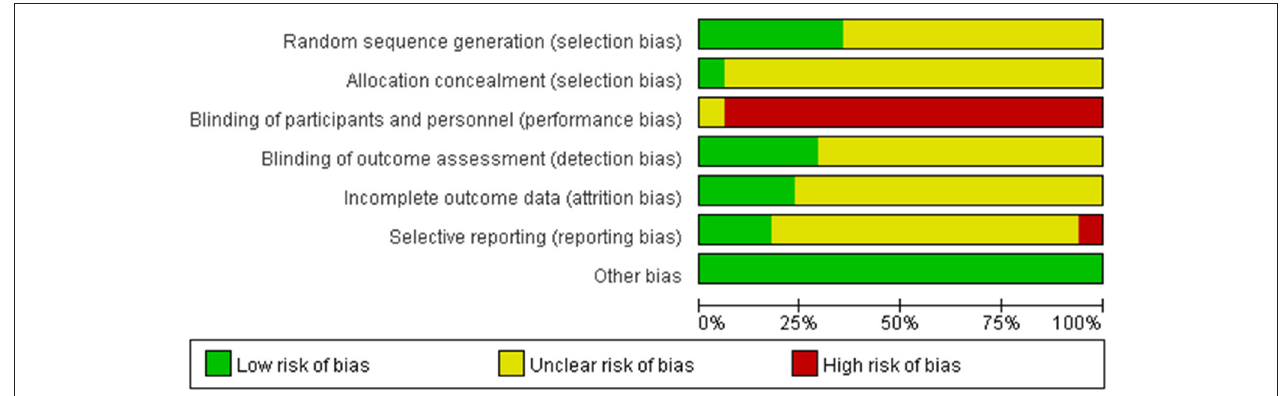
FIGURE 2 | Risk of bias